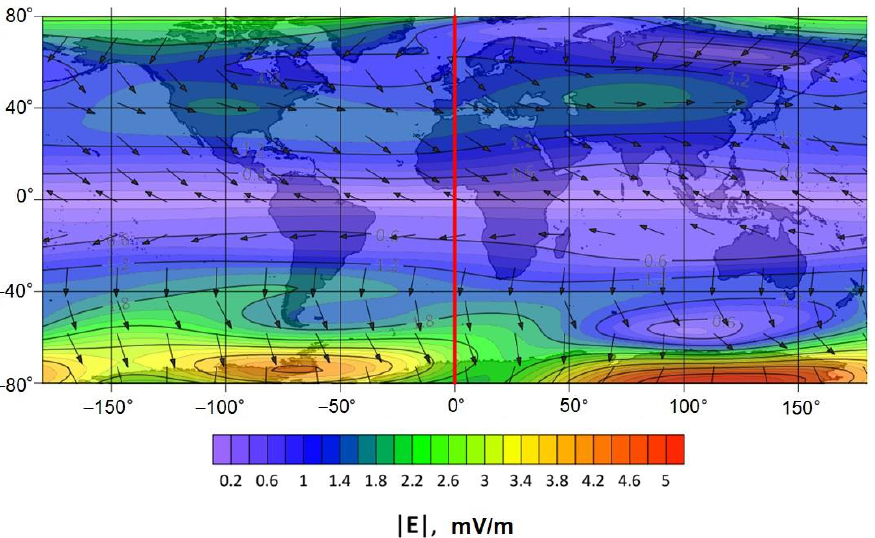
and its vector in the lower ionosphere for the same parameters.